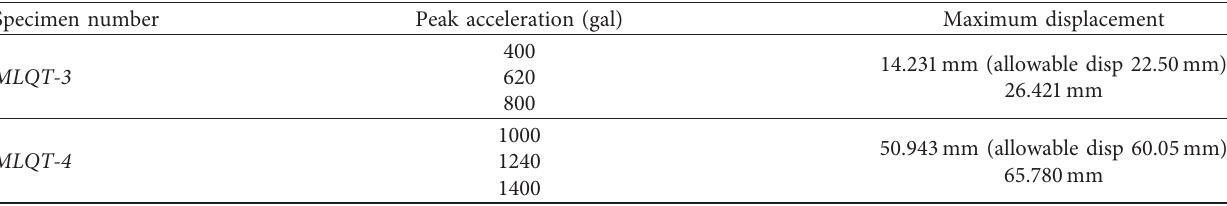
Table 4: MLQT-3\MLQT-4 displacement.